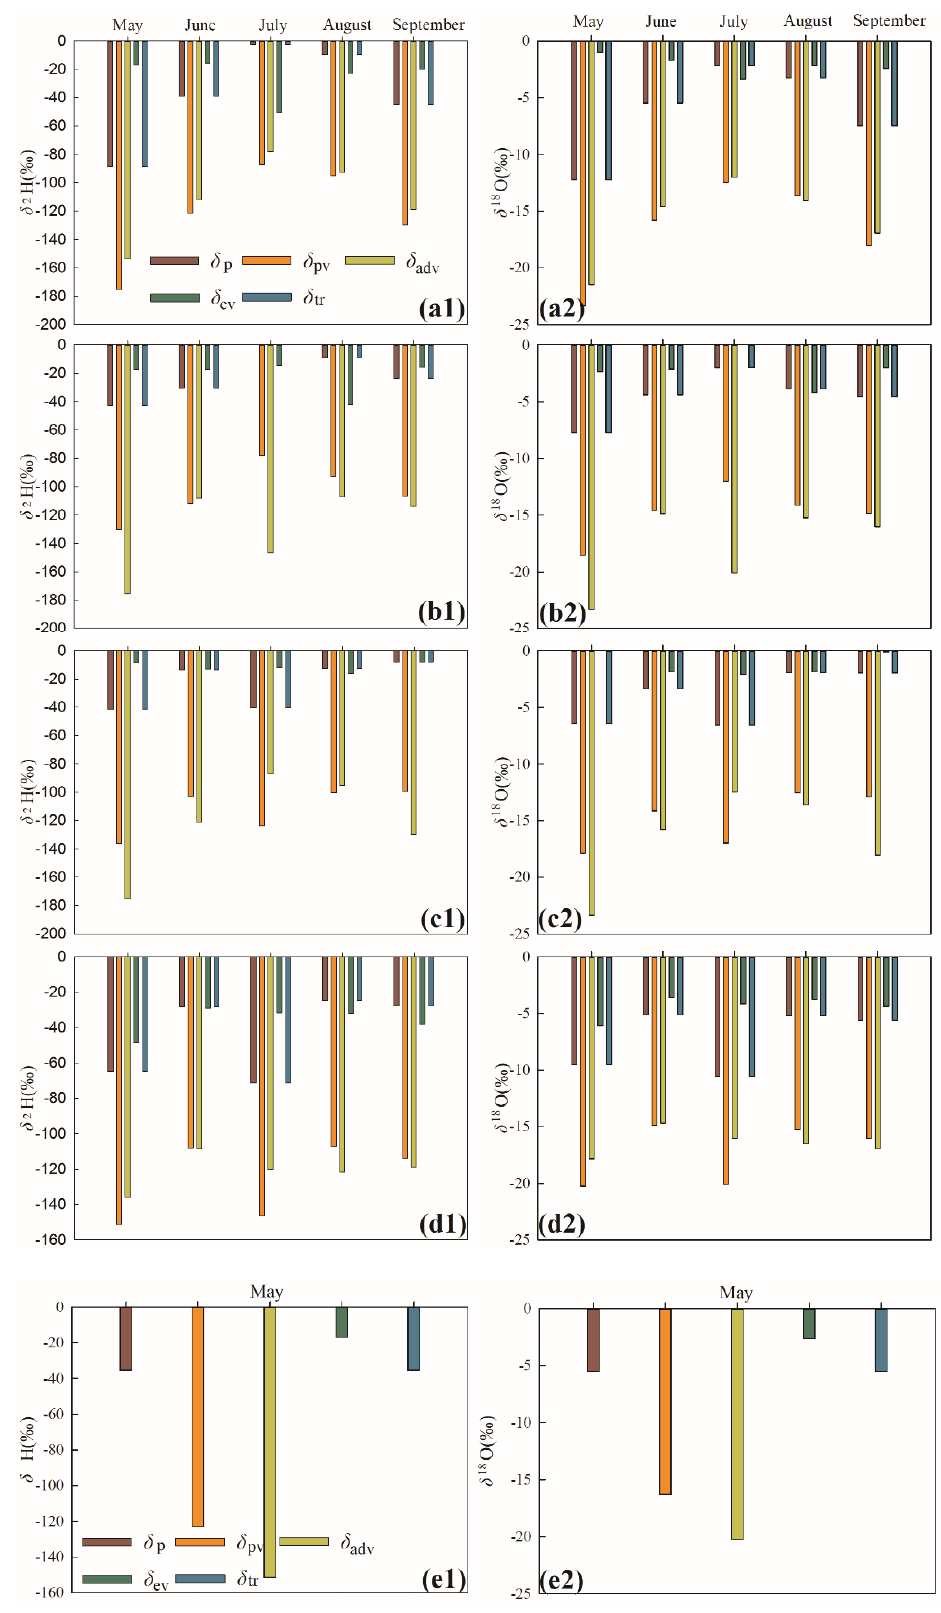
Figure 4. Monthly isotope composition of δ p -precipitation, δ pv -precipitation vapor, δ adv -advected vapor, δ ev -evaporated vapor and δ tr -transpirated vapor ( a1 , a2 -Sunan; b1 , b2 -Gulang; c1 , c2 -Yeniugou; d1 , d2 -Wushaoling; e1 , e2 -Tianzhu).